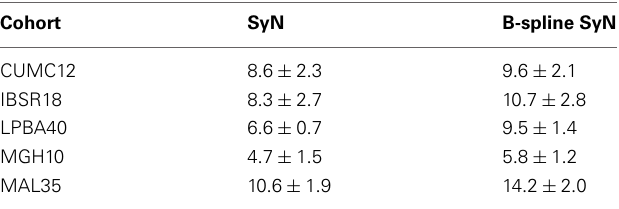
Table 2 | Timing (in hours) per registration for both SyN algorithms across data